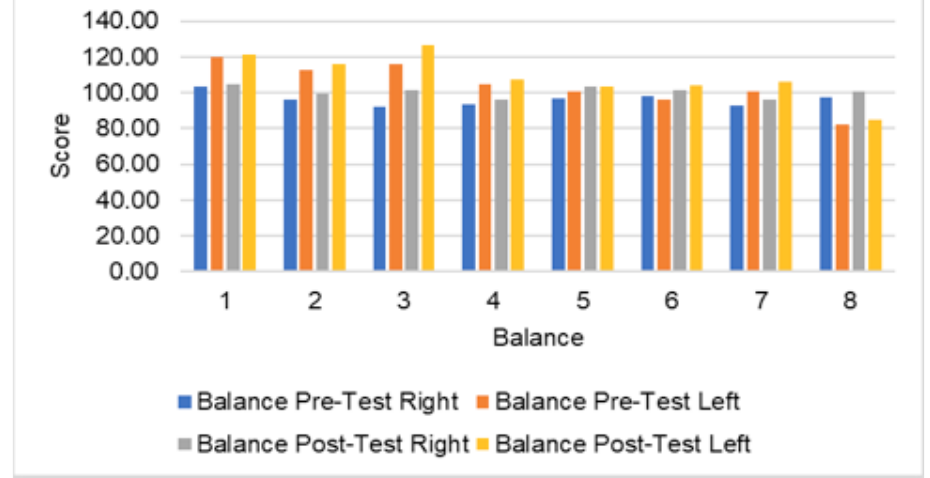
Figure 7. Data of balance theraband exercise 18 years old